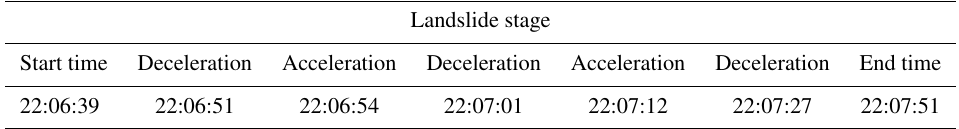
Table 2. The beginning characteristic stage of the Baige landslide river blocking event picked by seismic signal recorded at GZI station (all times are UTC +